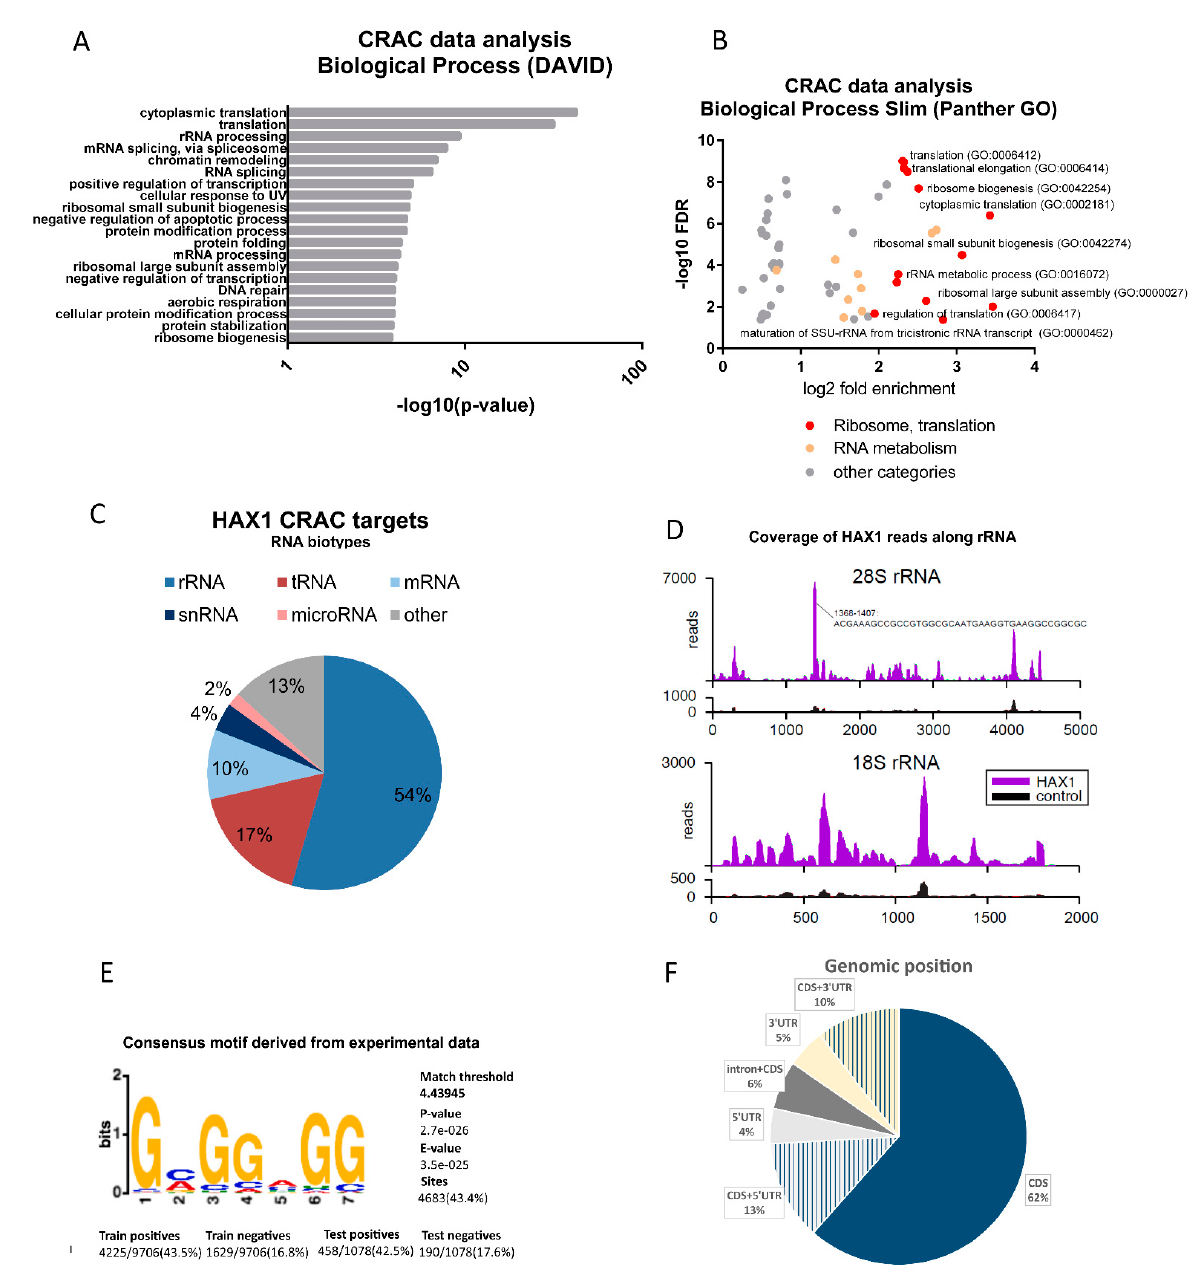
Figure 3. Identification of HAX1-associated RNA targets by CRAC analysis (HEK293 cells). ( A ) Functional annotation enrichment of HAX1 target genes (results from the pooled N- and C-tagged protein approach). Enriched gene ontology terms (DAVID: Biological Process) presented in bar plot, the length of each bar corresponds to statistical significance of the enrichment (-log10 p -value). The top 20 terms are presented for each category. ( B ) Enriched Biological Process terms (Panther GO) plotted with fold enrichment (log2) against false discovery rate (-log10). The most reliable results are in the upper right corner. Terms associated with ribosome biogenesis, rRNA processing, and translation are marked red. Terms associated with RNA metabolism (other than rRNA) are marked in light orange. Detailed description of GO terms in Supplemental Data File S2. ( C ) Distribution of RNA species in HAX1 targets. ( D ) Coverage of HAX1 CRAC reads along small (18S) and large (28S) ribosomal subunits. Reads for negative control shown below. ( E ) Consensus motif identified by STREME in the HAX1-targets dataset (combined experimental data from C- and N-tagged HAX1). The E-value is the p -value multiplied by the number of motifs reported by STREME. ( F ) Genomic position of HAX1 binding in CRAC-identified targets (269 targets overlapping in C- and N-tagged datasets) established using UCSC Genome Browser on Human Feb. 2009 (GRCh37/hg19) Assembly.